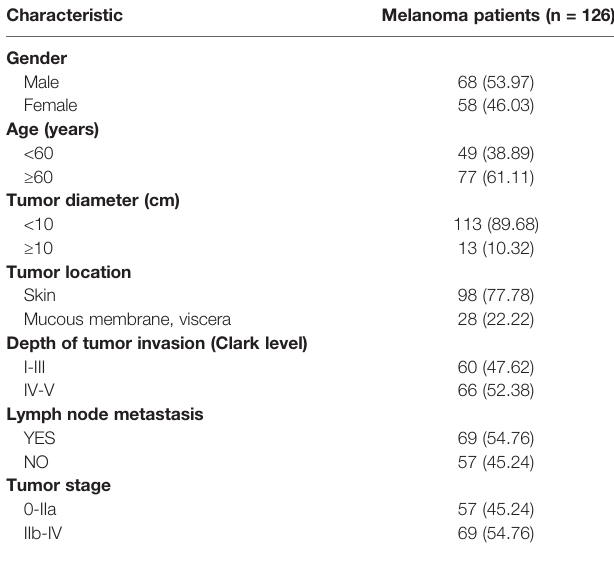
TABLE 1 | Baseline characteristics of enrolled melanoma